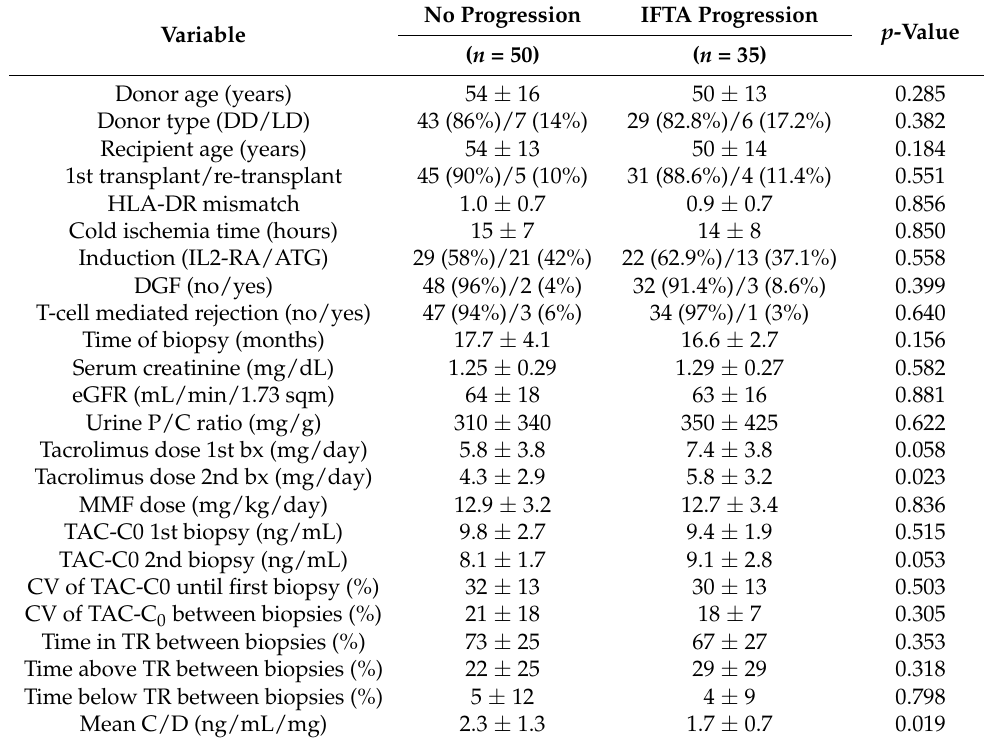
Table 6. Clinical and therapeutic drug monitoring data in patients with and without interstitial fibrosis and tubular atrophy progression between